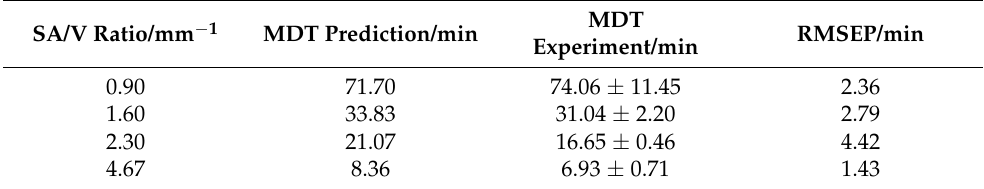
Table 4. Comparison of MDT: predicted vs. experimental data of the PVA-PDM formulation ( n ≥ 3; x ± s).